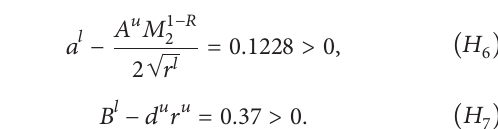
One could easily see